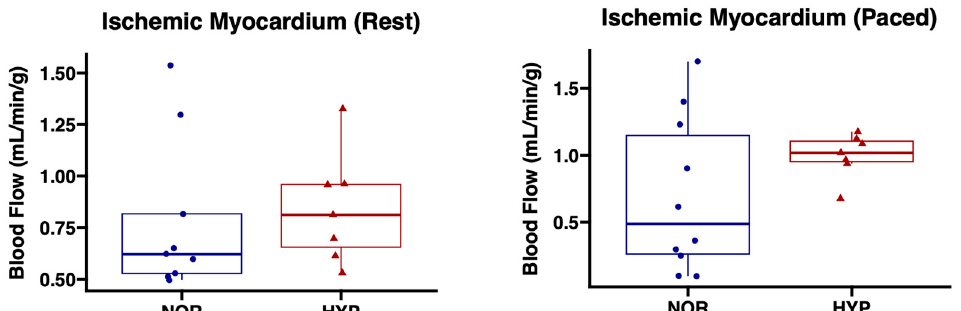
Figure 2. Perfusion to chronically ischemic myocardium was not significantly changed with hy- poxia-modified EVs compared to normoxia EVs. Swine treated with hypoxia-modified (HYP, n = 7) EVs had nonsignificant trends towards increased perfusion to chronically ischemic myocardial ter- ritory compared to swine treated with normoxia serum-starved EVs (NOR, n = 10). Upper and lower borders of box represent upper and lower quartiles; middle horizontal line represents median; up- per and lower whiskers represent maximum and minimum values.